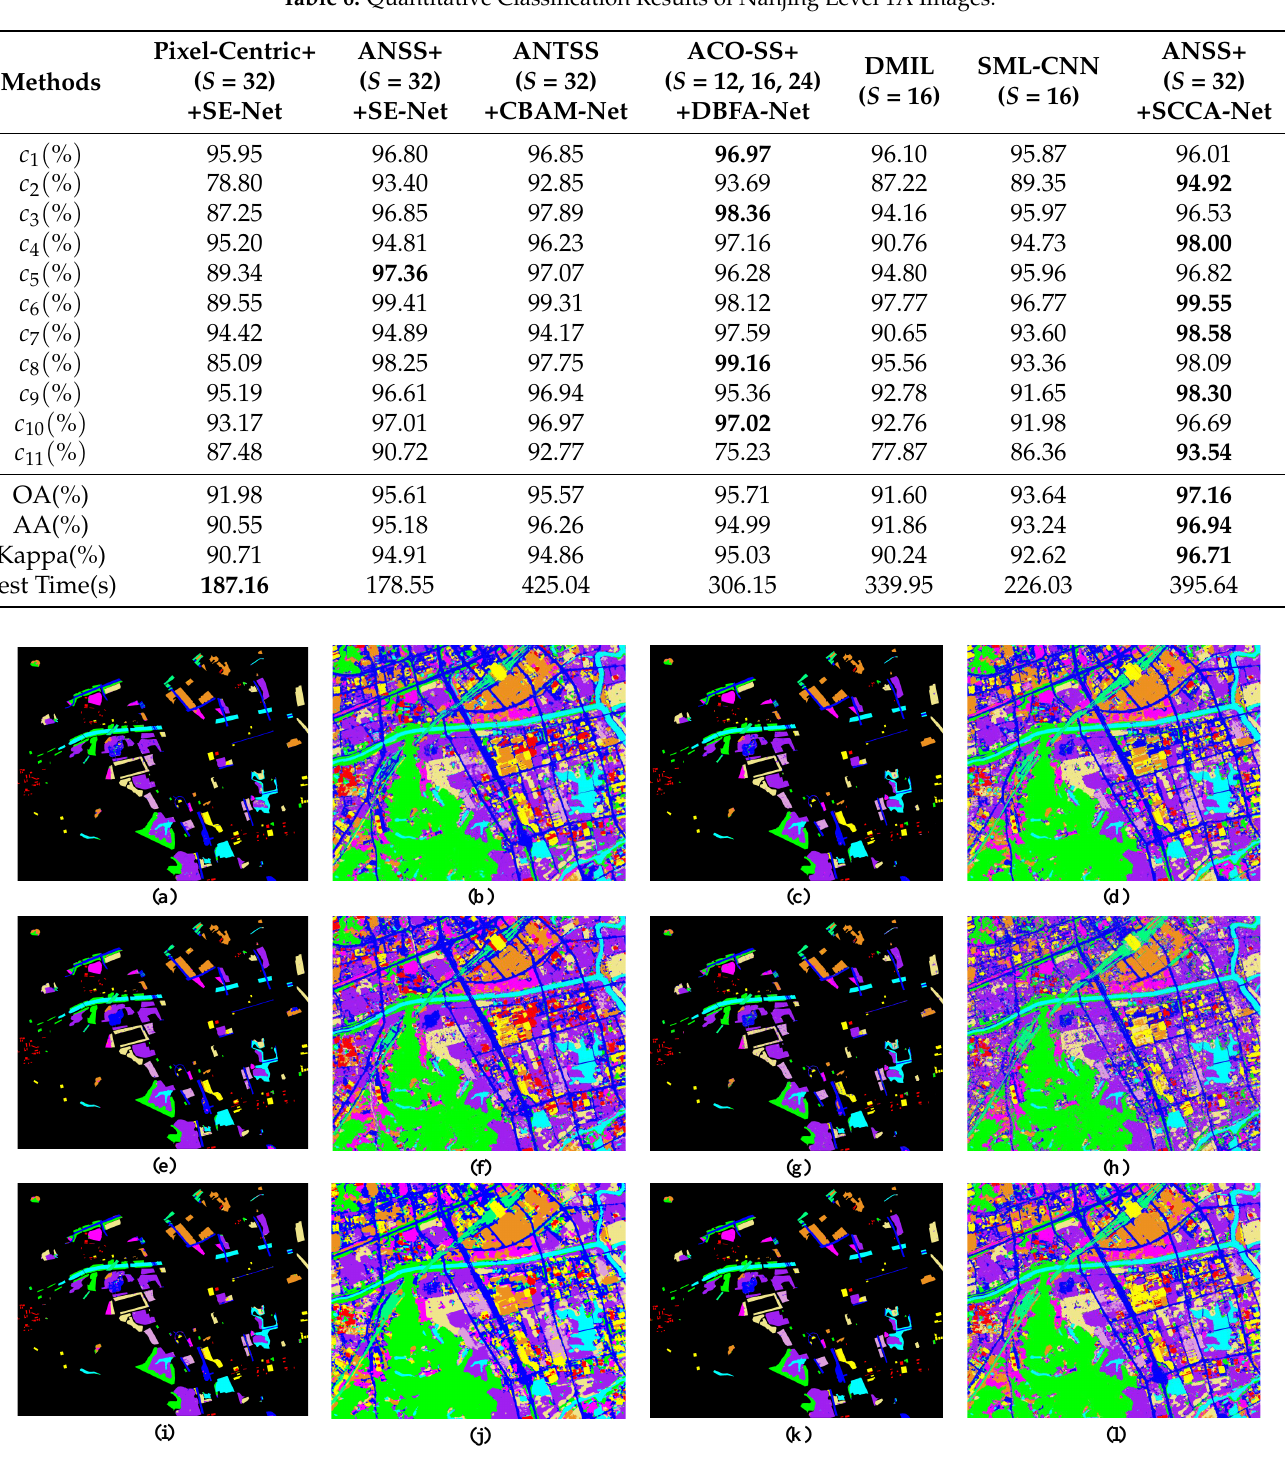
Figure 10. Classification maps of different methods on the Nanjing Level 1A Images (2000 × 2500), each method has two classification maps: one is image with ground truth, while the other is overall image. ( a , b ) Pixel-Centric+SE-Net(Res18). ( c , d ) ANTSS+SE-Net(Res18). ( e , f ) ACO-SS+DBAF-Net. ( g , h ) DMIL. ( i , j ) SML-CNN ( k , l )